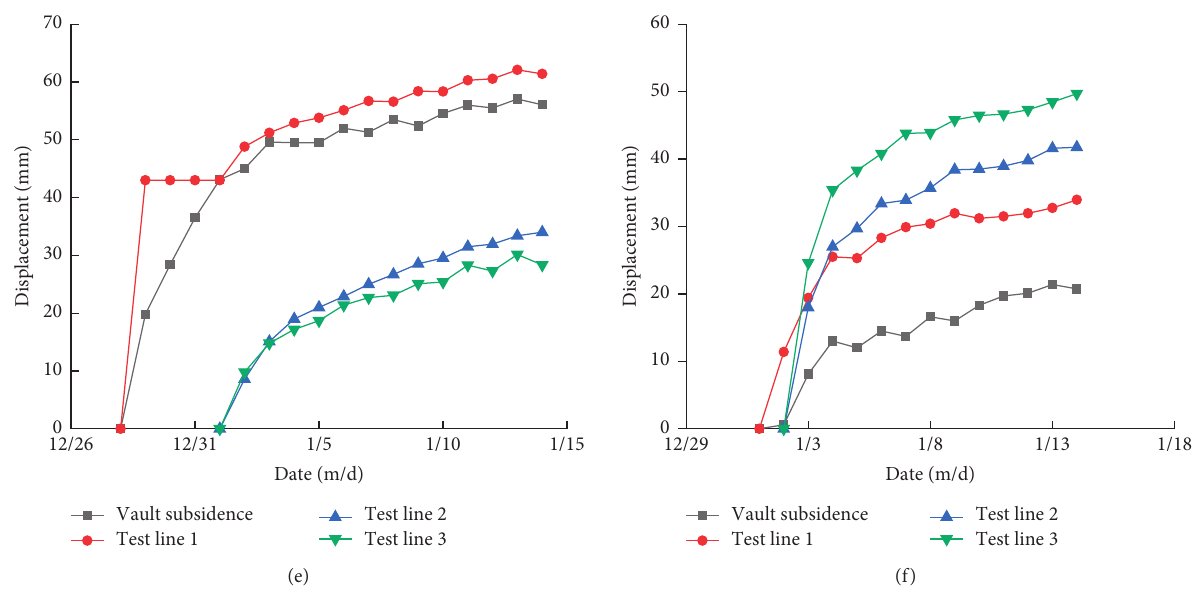
Figure 13: Time-history curves of vault subsidence and horizontal convergence. (a) DK390 +175. (b) DK390 +170. (c) DK390 +165. (d)